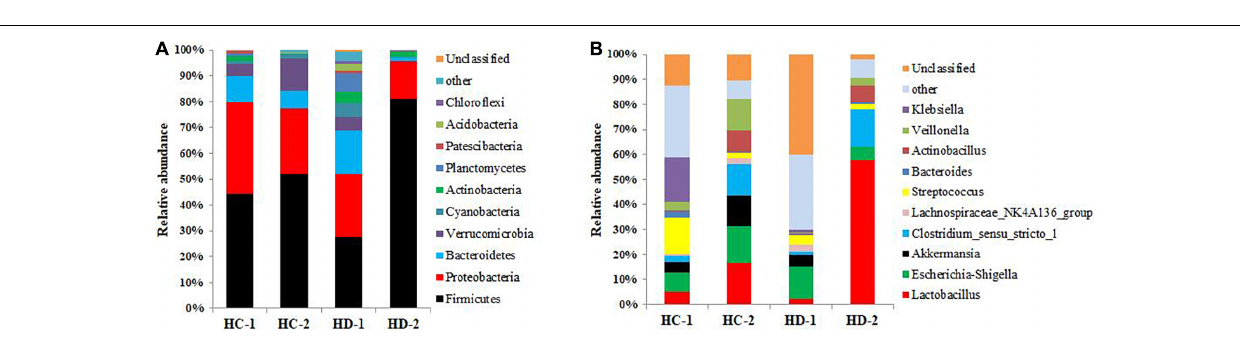
Lachnospiraceae_NK4A136_group than non-Hoxa1 − / −